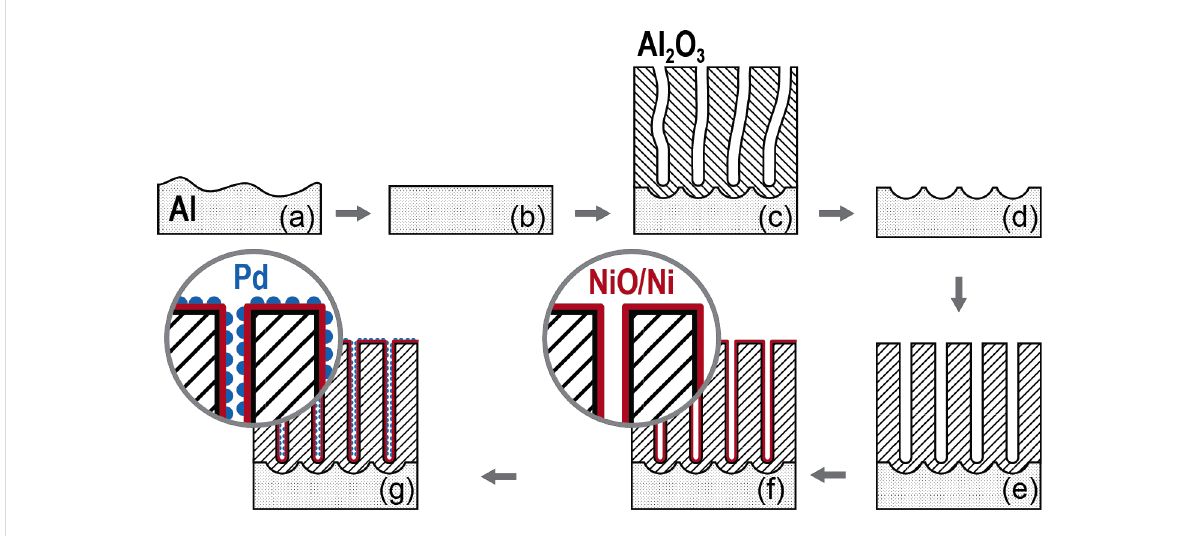
Figure 1: Schematic description of the anodic alumina template fabrication and successive functionalization. (a) Initial Al disc, (b) electropolished Al disc, (c) anodic Al 2 O 3 porous layer, (d) pre-ordered Al disc after removal of the AAO sacrificial layer, (e) self-ordered AAO membrane, (f) Ni/NiO film deposited by ALD and reduced by annealing post treatment, (g) Pd cluster layer grown by ALD.